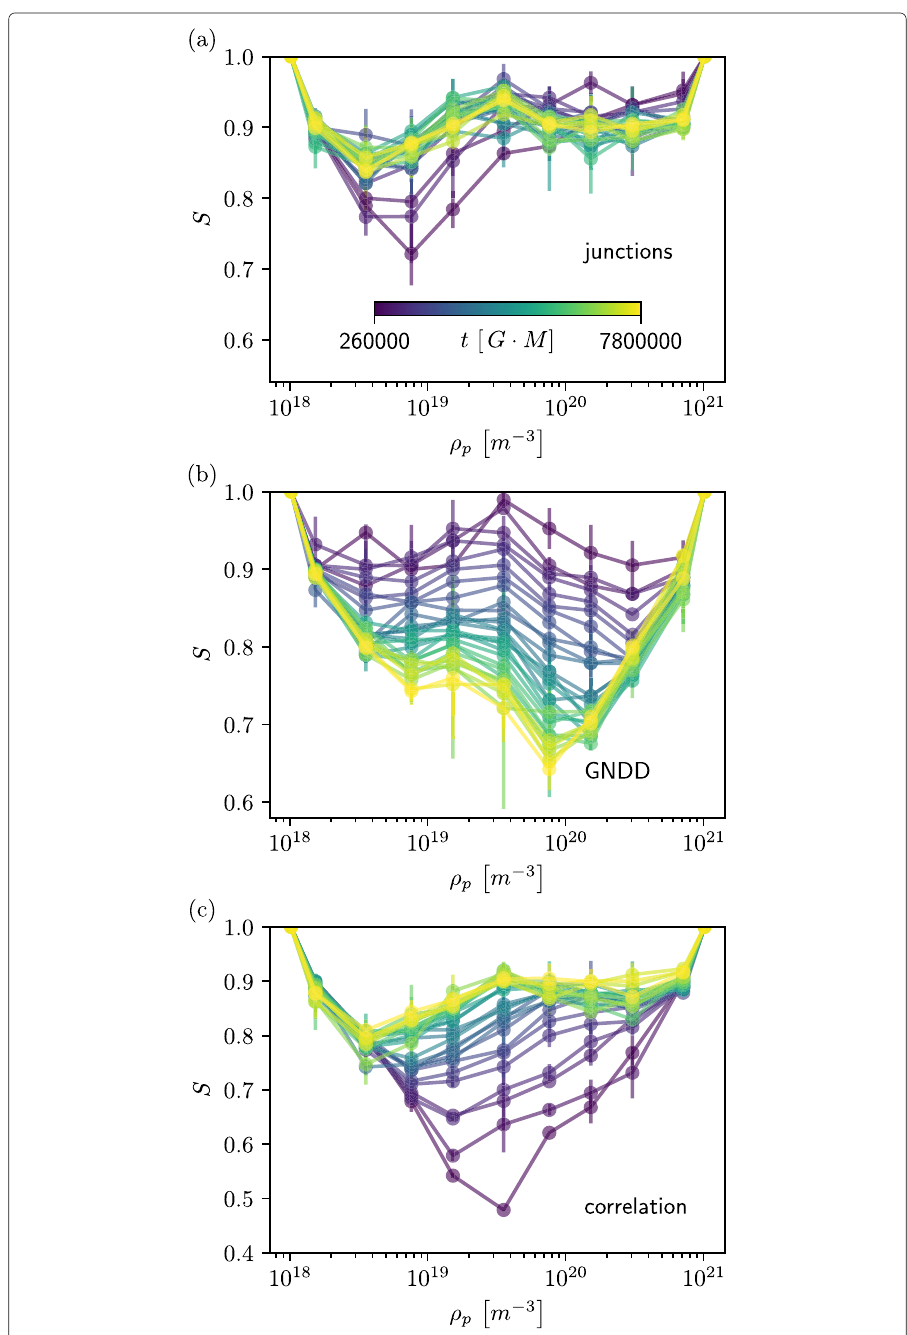
Fig. 7 The confusion curves with two principal components of single time step snapshot. Used features are a junction lengthening, b GND density change, c dislocation correlation. The number of collected systems starts to decrease after t = 4.7 · 10 6